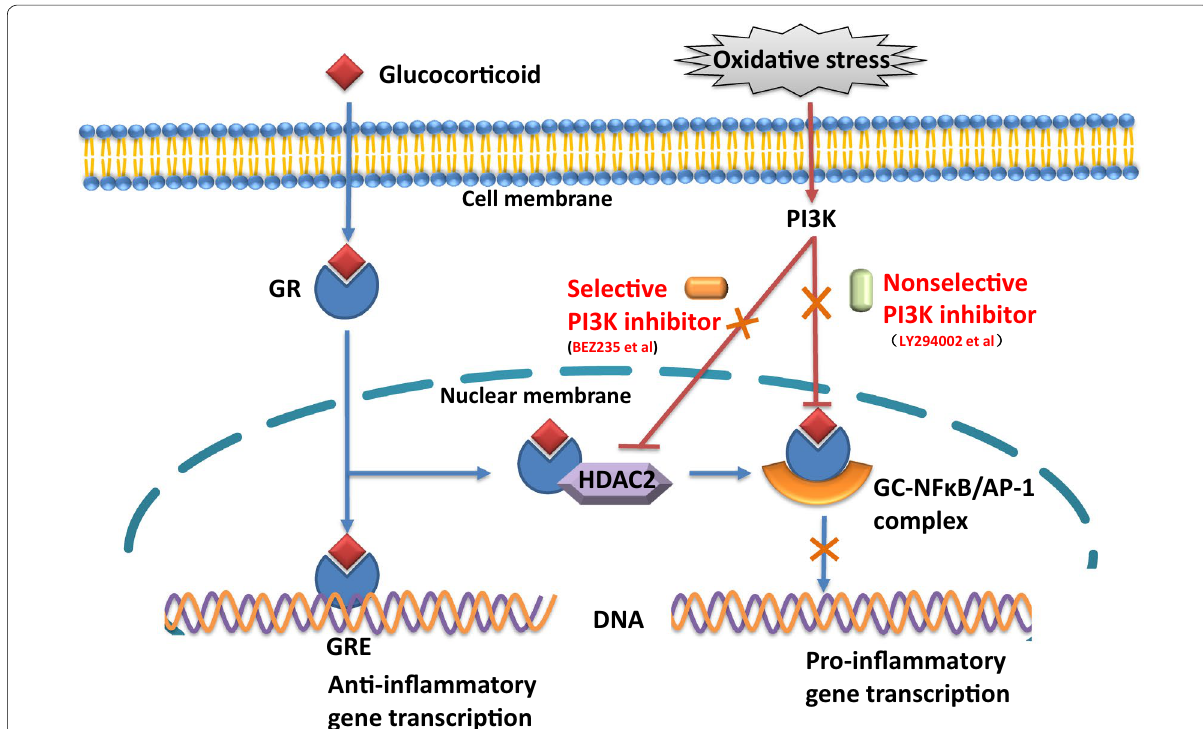
Fig. 8 Possible mechanism by which PI3K inhibitors ameliorate GC insensitivity in severe asthma. GC bind with GC receptors (GR) in the cytoplasm,then the GC-bound GR complex diffuse across the nuclear membrane where it binds to the glucocorticoid response element (GRE). The GRE is responsible for transcribing anti-inflammatory proteins. Additionally, binding of GC to GR results in recruitment of histone deacetylase 2 (HDAC2), which is responsible for deacetylating GR, permitting its binding to nuclear factor-kappa B (NF-κB) and activating protein-1 (AP-1). Upon binding, these transcription factors are deactivated, thereby inhibiting the transcription of pro-inflammatory proteins. Additionally, HDAC2 deacetylates the histone permitting transcription of anti-inflammatory genes by GR. In severe asthma, oxidative stress can activate phosphoinositide 3-kinase (PI3K) pathway. PI3K phosphorylation reduce HDAC2 activity, affect the balance between pro-inflammatory and anti-inflammatory gene transcription and finally decrease corticosteroid sensitivity. Selective PI3K inhibitor (BEZ235 et al.) can restore HDAC-2 activity, and nonselective PI3K inhibitor (LY294002 et al.) can directly inhibit phosphorylation of nuclear signal transcription factors and